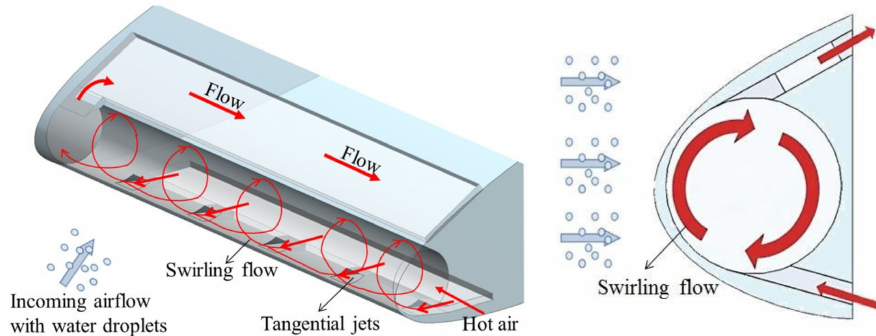
Figure 1. Schematic of swirling hot air anti-icing technology for aircraft